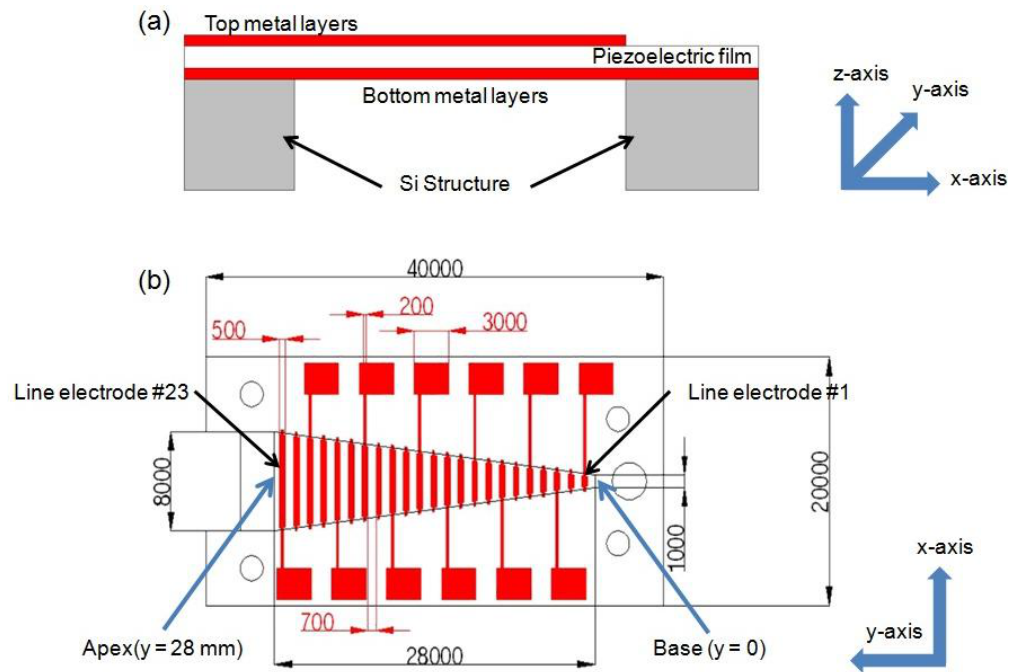
Figure 1. The schematic of artificial basilar membrane device from: ( a ) side view and ( b ) top view with dimensions in μm.